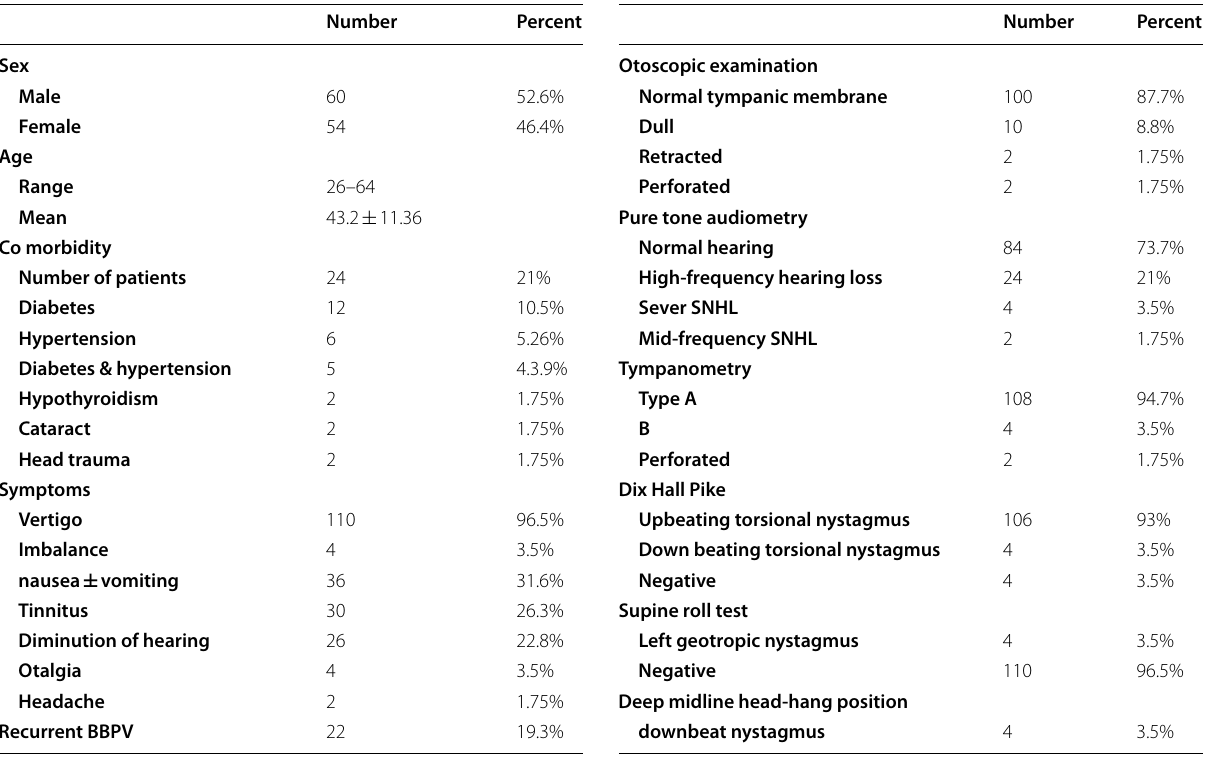
Table 2 Otoscopic, adudilogical, and vestibular assessments